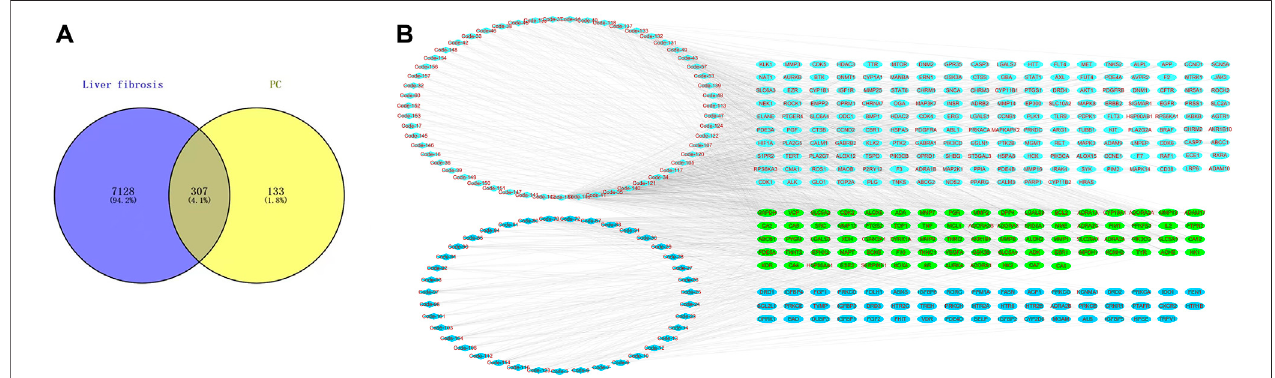
FIGURE5 | Network Pharmacology analysis ofthe P. chinense for liver fi brosis treatment. (A) Candidate targetscreening of P. chinense for liver fi brosis treatment. (B) Compound network of the P. chinense (light green represents fl avonoids, and blue represents phenolic acids). The rectangle represents different compounds in P. chinense , and ellipse nodes represent active